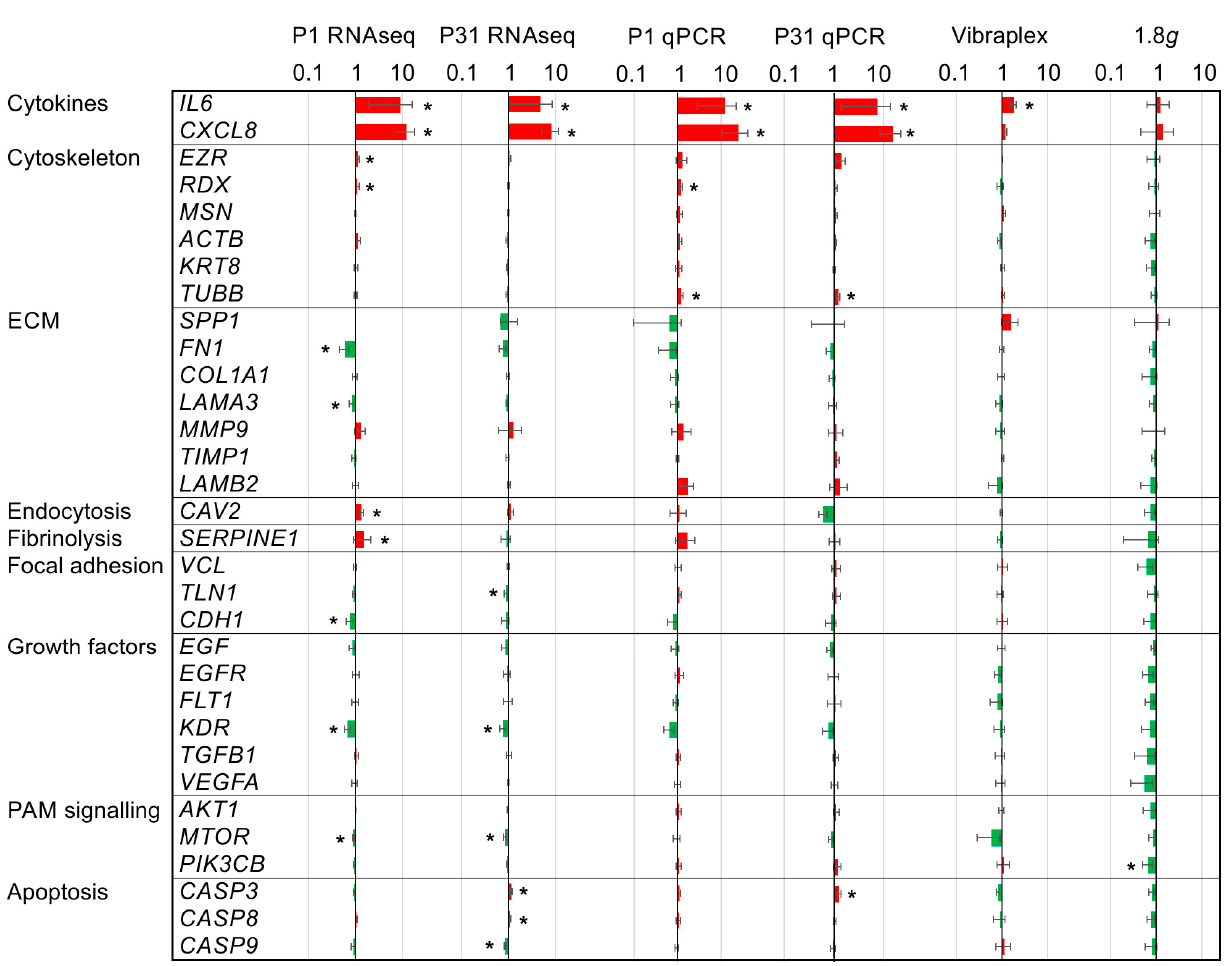
Figure 1. Gene expression ratios of 32 key players of carcinogenesis in PC-3 prostate cancer cells under altered gravitational conditions measured by qPCR and RNAseq: Results determined after P1, after P31, after vibration-exposure and after hypergravity (1.8 g )-exposure in relation to the respective 1 g control samples. The red color indicates upregulated genes and the green color downregulated genes. Significant changes (nominal p < 0.05) are indicated by asterisks. The ratios are given on a logarithmic scale.